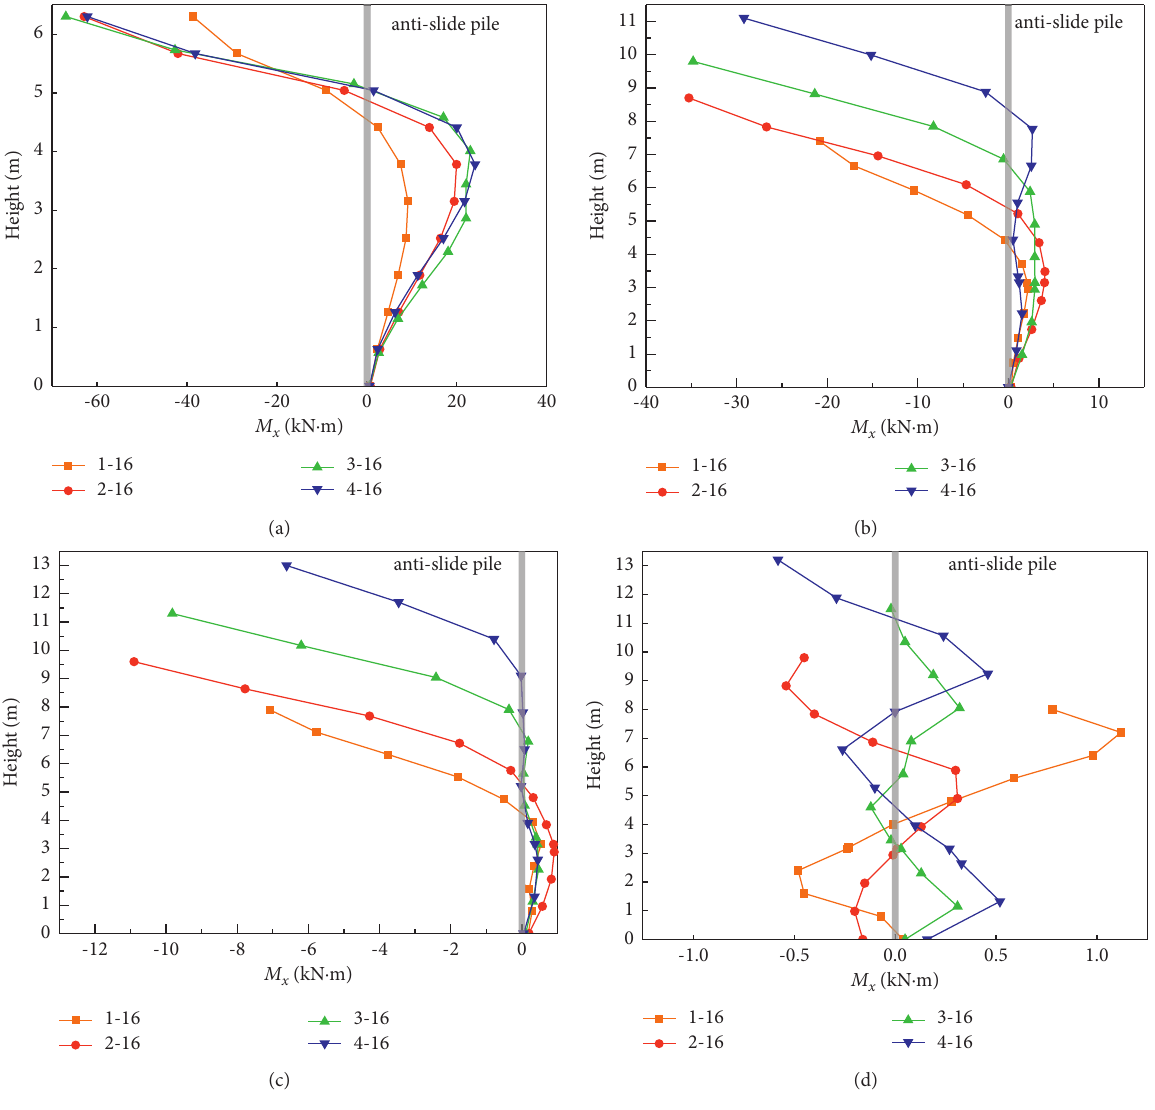
Figure 5: M x : (a) P1; (b) P3; (c) P5; (d)